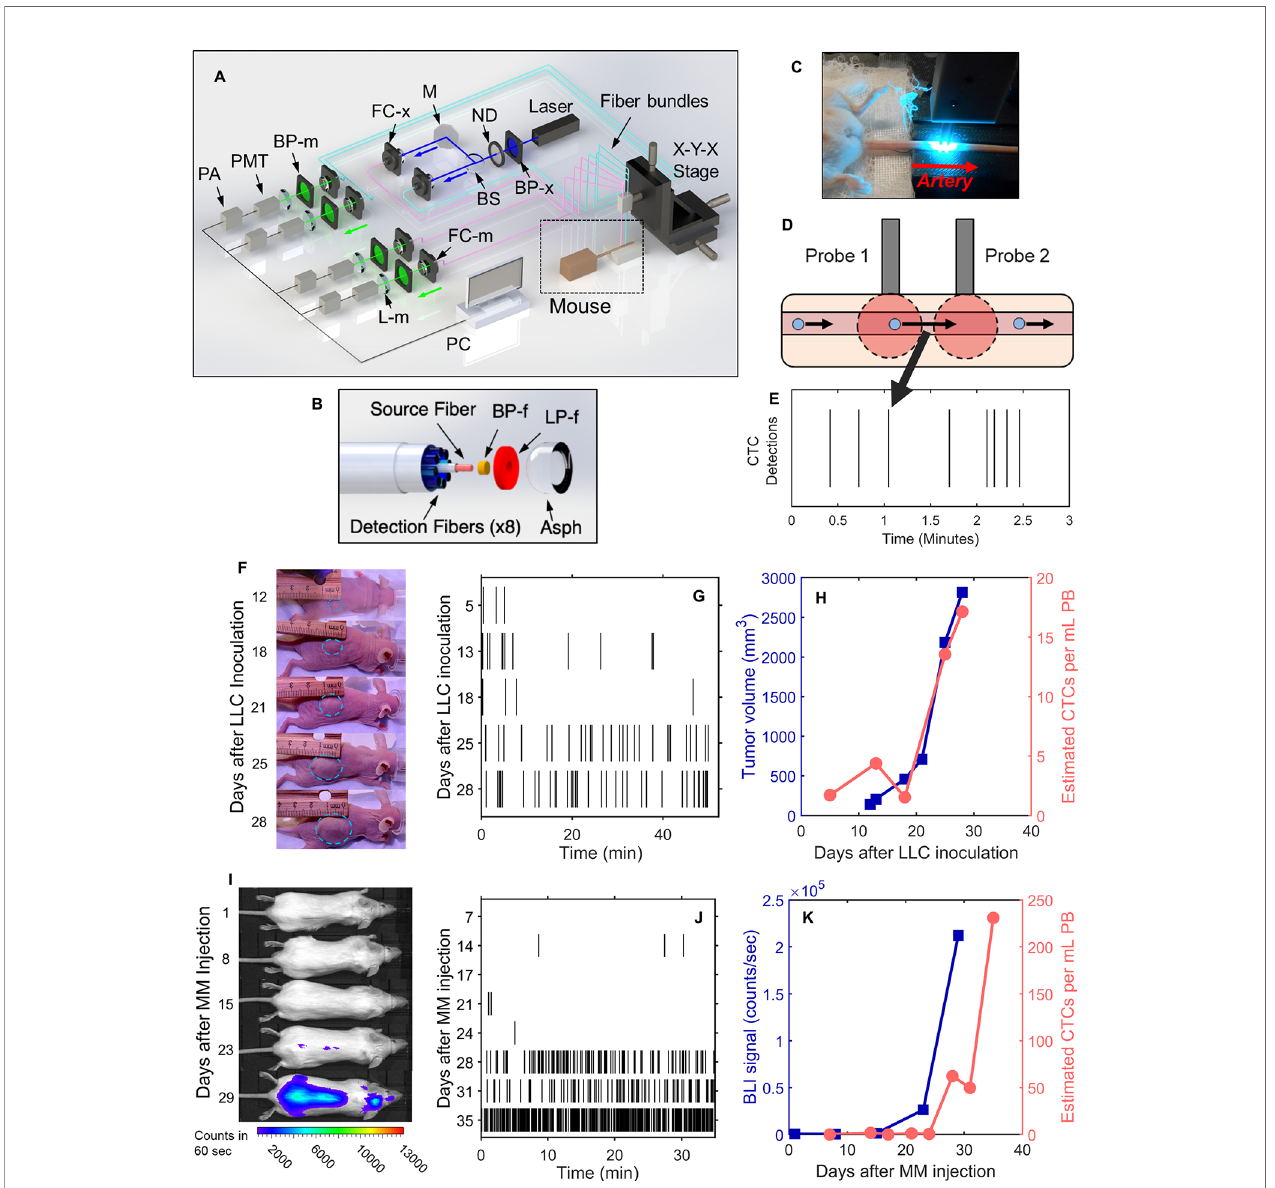
FIGURE 1 | DiFC allows non-invasive in vivo enumeration of rare circulating tumor cells (CTCs) in mice without drawing blood samples. (A) The DiFC instrument was described in detail previously (27, 29). The specially designed DiFC probes use two specially designed (B) optical fi ber bundles that are placed on the (C) skin surface over the ventral side of the tail of a mouse. (D) When GFP-expressing CTCs pass through the DiFC fi eld of view, the GFP is excited and the resulting fl uorescent emission is detected by the probes. (E) The emission is identi fi ed as a CTC detection in time, which is visualized as a vertical black line on a raster plot. (F – H) A representative data set collected from an s.c. LLC-tumor bearing mouse. (F) Photographs of LLC tumor growth. (G) DiFC raster of CTC detections during tumor growth. (H) The tumor volume (blue squares) and mean rate of CTC detections (pink circles) over time. (I – K) Example MM-DXM mouse data. (I) Bioluminescence (BLI) images during MM growth. (J) DiFC raster plots of MM CTC detections. (K) BLI signal (blue squares) and mean rate of CTC detections (pink circles) over time. Panels (A, B) reproduced with permission from Patil et al.